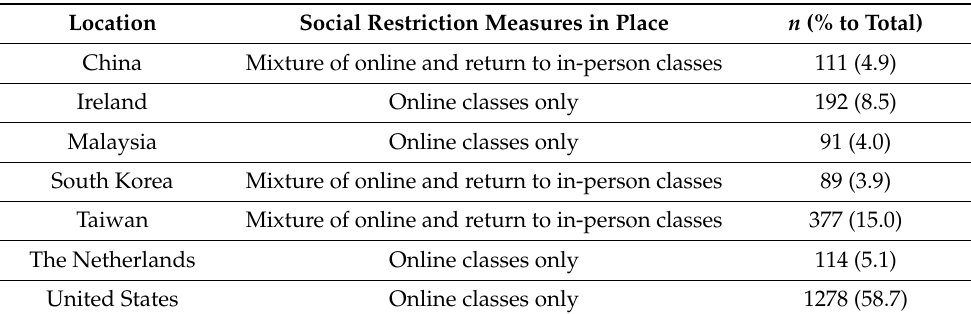
Table 2. Social restriction information and sample size by location.